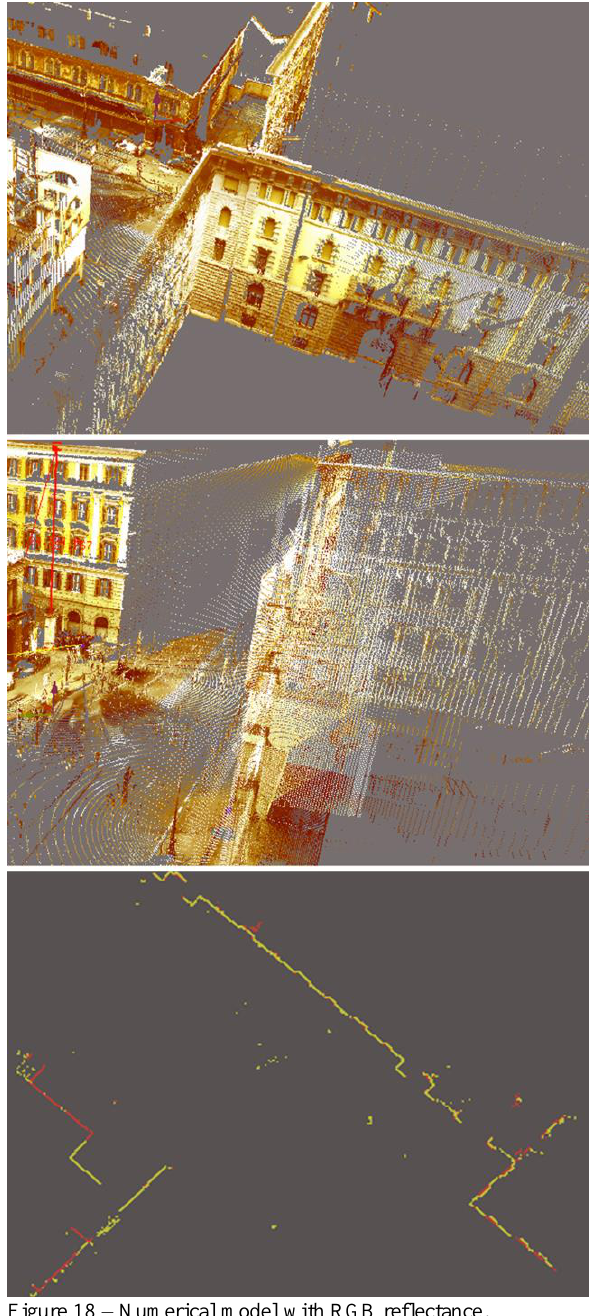
Figure 18 – Numerical model with RGB reflectance. 3) The solutions adopted are useful for the chronological verification and the state of conservation of a